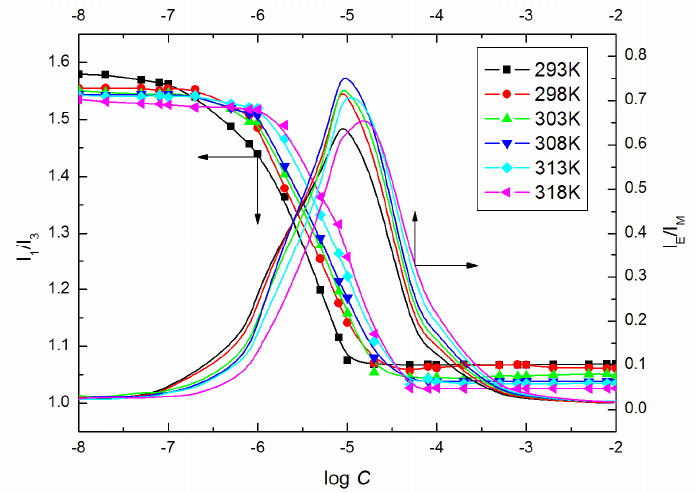
/ I I determined from the fluorescence spectra of II / and 1 3 ME